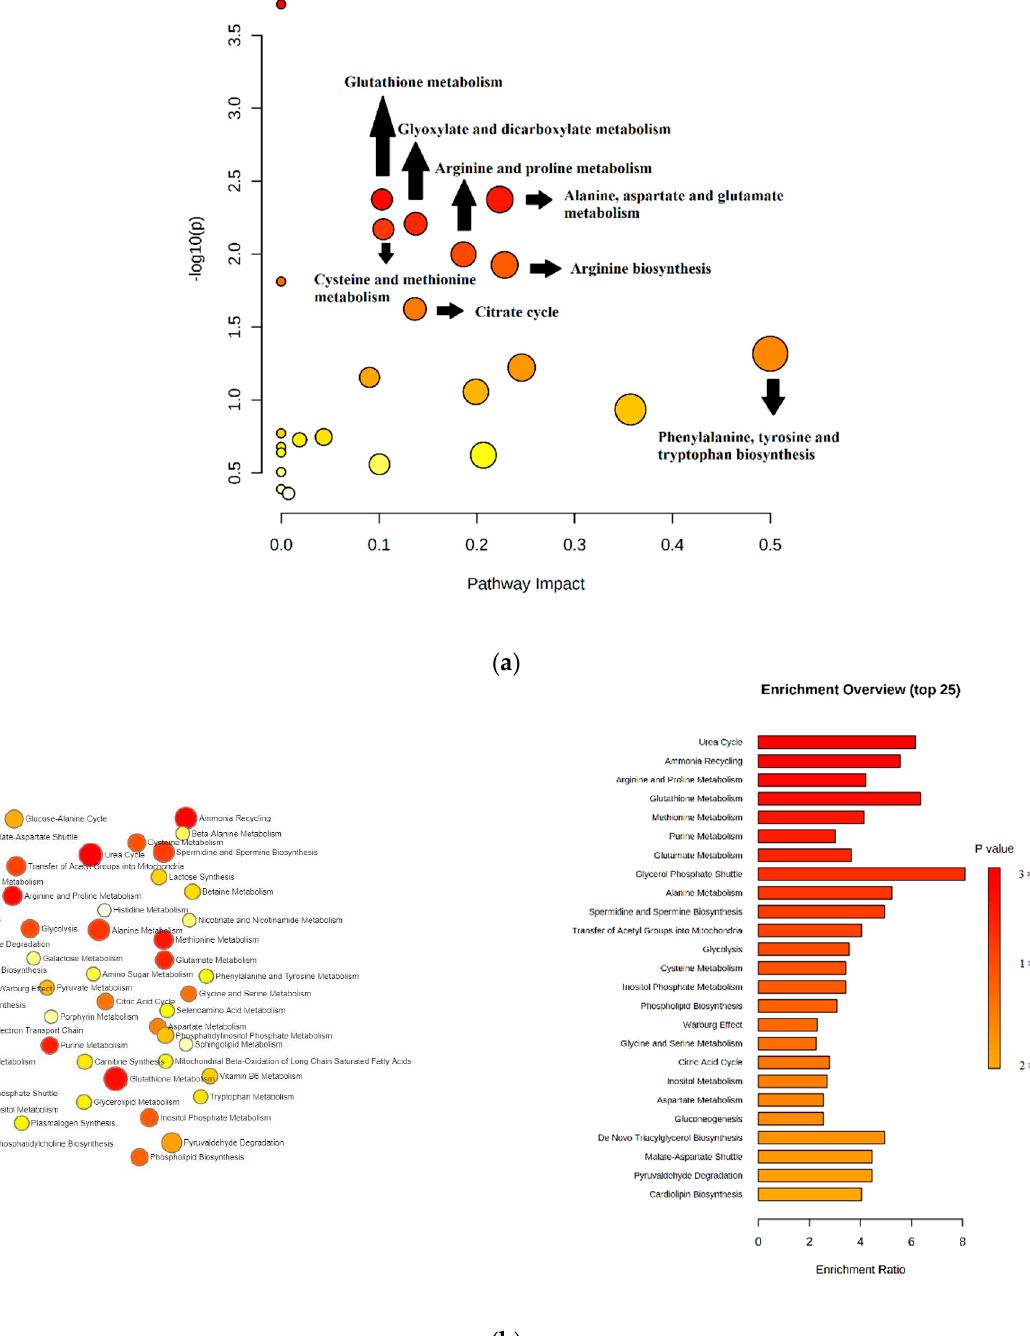
Figure 8. Pathways’ analysis plot of the disturbed metabolic pathways in dogs infected with B. canis compared to healthy dogs ( a ). Glutathione metabolism, as well as alanine, aspartate, and glutamate metabolism, glyoxylate and dicarboxylate metabolism, cysteine and methionine metabolism, arginine and proline metabolism, arginine biosynthesis, citrate cycle and phenylalanine, tyrosine, and tryptophan biosynthesis were significant pathways with a p value of <0.05 and impact of >0.1. Biological pathways network and summary plot derived from metabolite set enrichment analysis for prediction of pathways associated serum metabolites sets ( b ). The colors and the bar length represent the metabolites with different levels of significance for enrichment analysis.